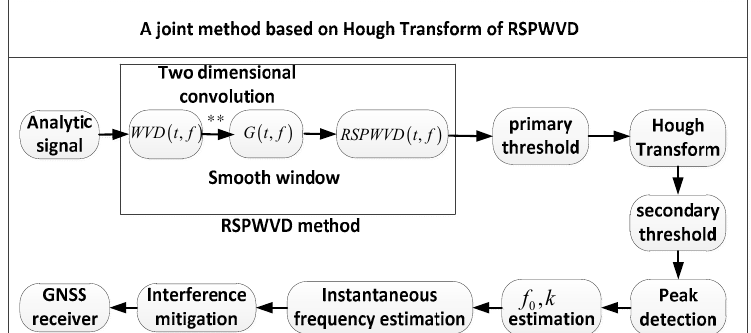
Figure 3. Block diagram of the joint method based on the Hough transform of RSPWVD to detect chirp interferences.